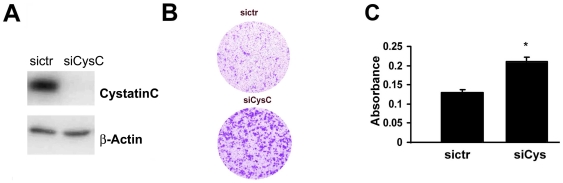
The effect of knockdown of cystatin C on the invasion of PC3 cells.
A). Immunoblotting of cystatin C in PC3 cells after treatment with control (siCtr) and cystatin C (siCys) siRNA. B–C) Invasion assay in matrigel- coated Boyden chambers of PC3 cells with knockdown of cystatin C. Representative image of invading cells is shown in (B) and quantitative analysis of invasion by measuring absorbance after staining of invading cells with Cell Stain Solution containing crystal violet supplied in the Transwell Invasion assay (Chemicon, Millipore, CA) (C) Data±SD are representative for at least 3 experiments;* p<0.01 (Student T-test).